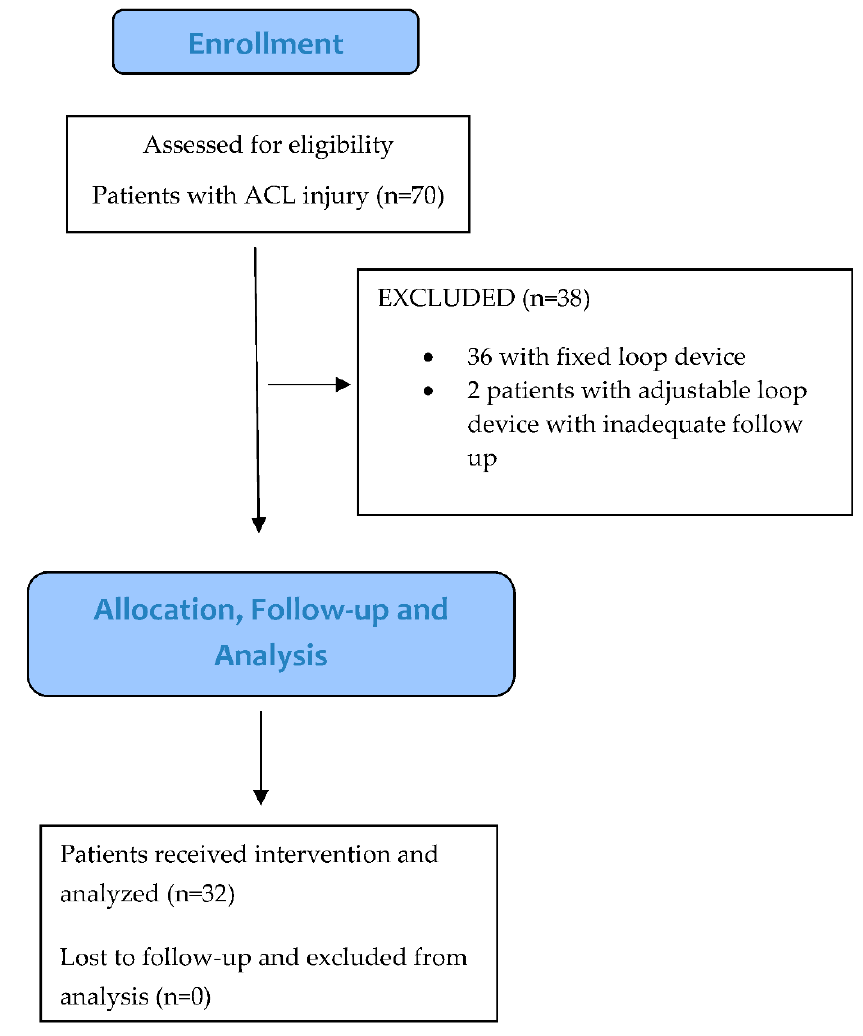
Figure 1. Flow chart showing recruitment, inclusion, and exclusion of